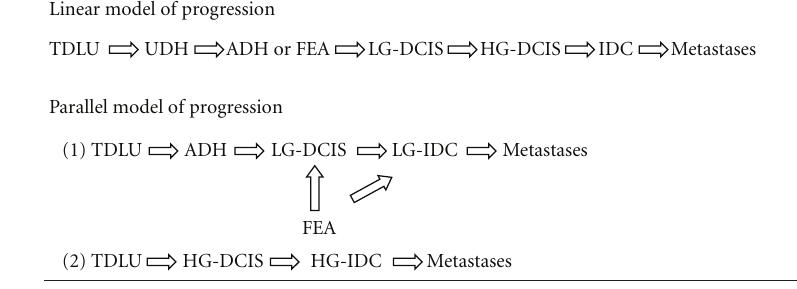
Table 3: Cancerogenesis models.